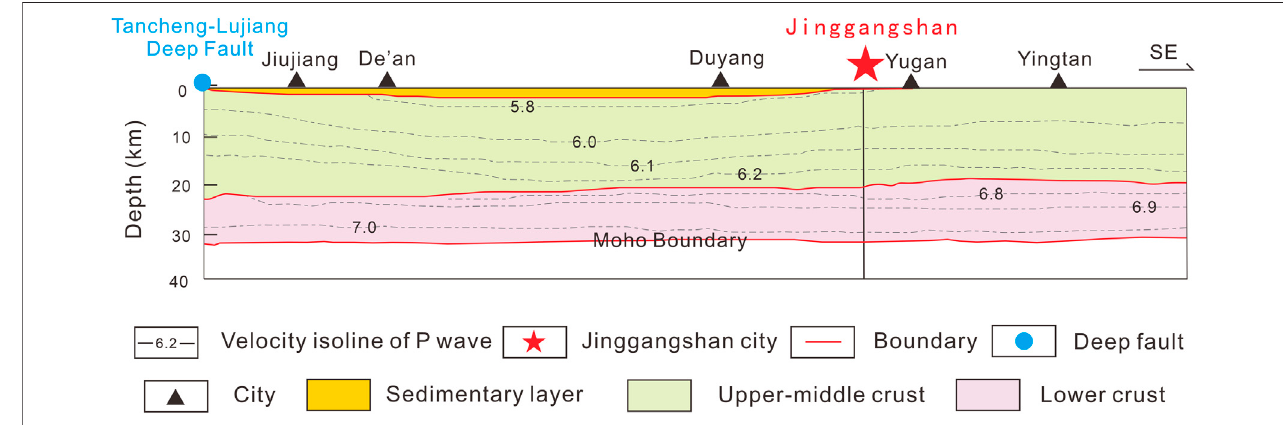
FIGURE4| DistributionofP-wavevelocityinthegeologicaltransectfromMenyuantoNingdeZuoyi(modi fi edaftertheEditorialCommitteeofGeoscienceTransect C E a E, (1994); Wang et al. (1995); the location of the section line is de fi ned in Figure 1 ).